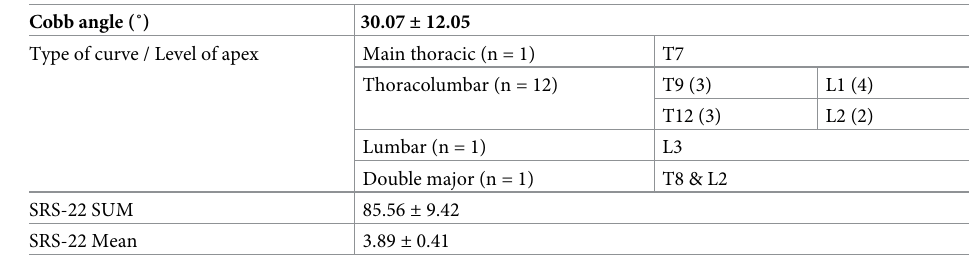
Table 2. Characteristics of the AIS